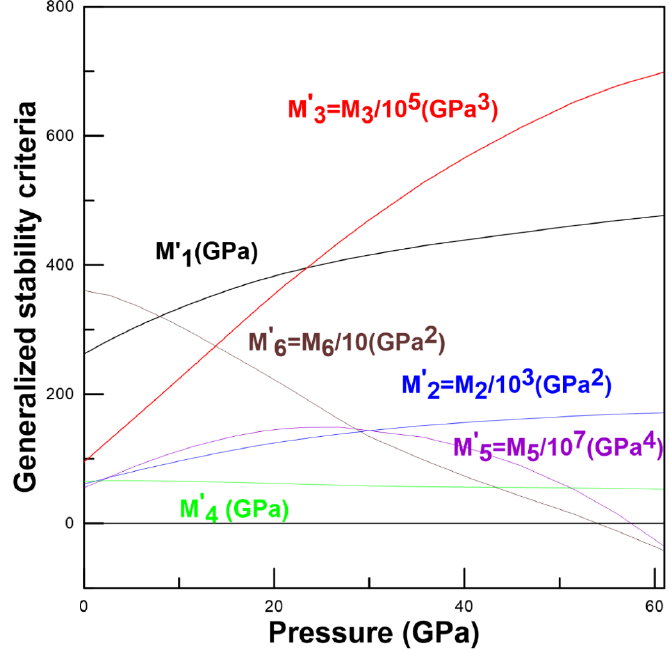
Figure 5. (Color online) Generalized stability criteria for monazite-type GdPO 4 . Figure 5. ( Color online ) Generalized stability criteria for monazite-type GdPO 4